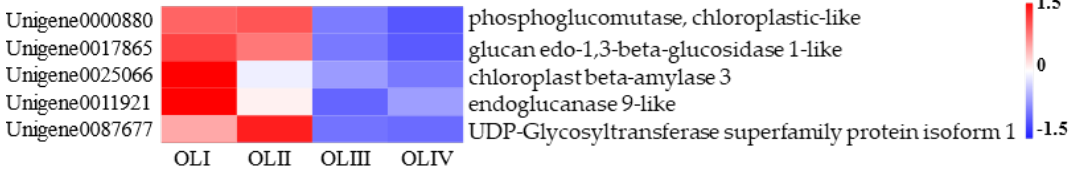
Figure 7. The heatmap showed the DEGs associated with starch and sucrose metabolism.